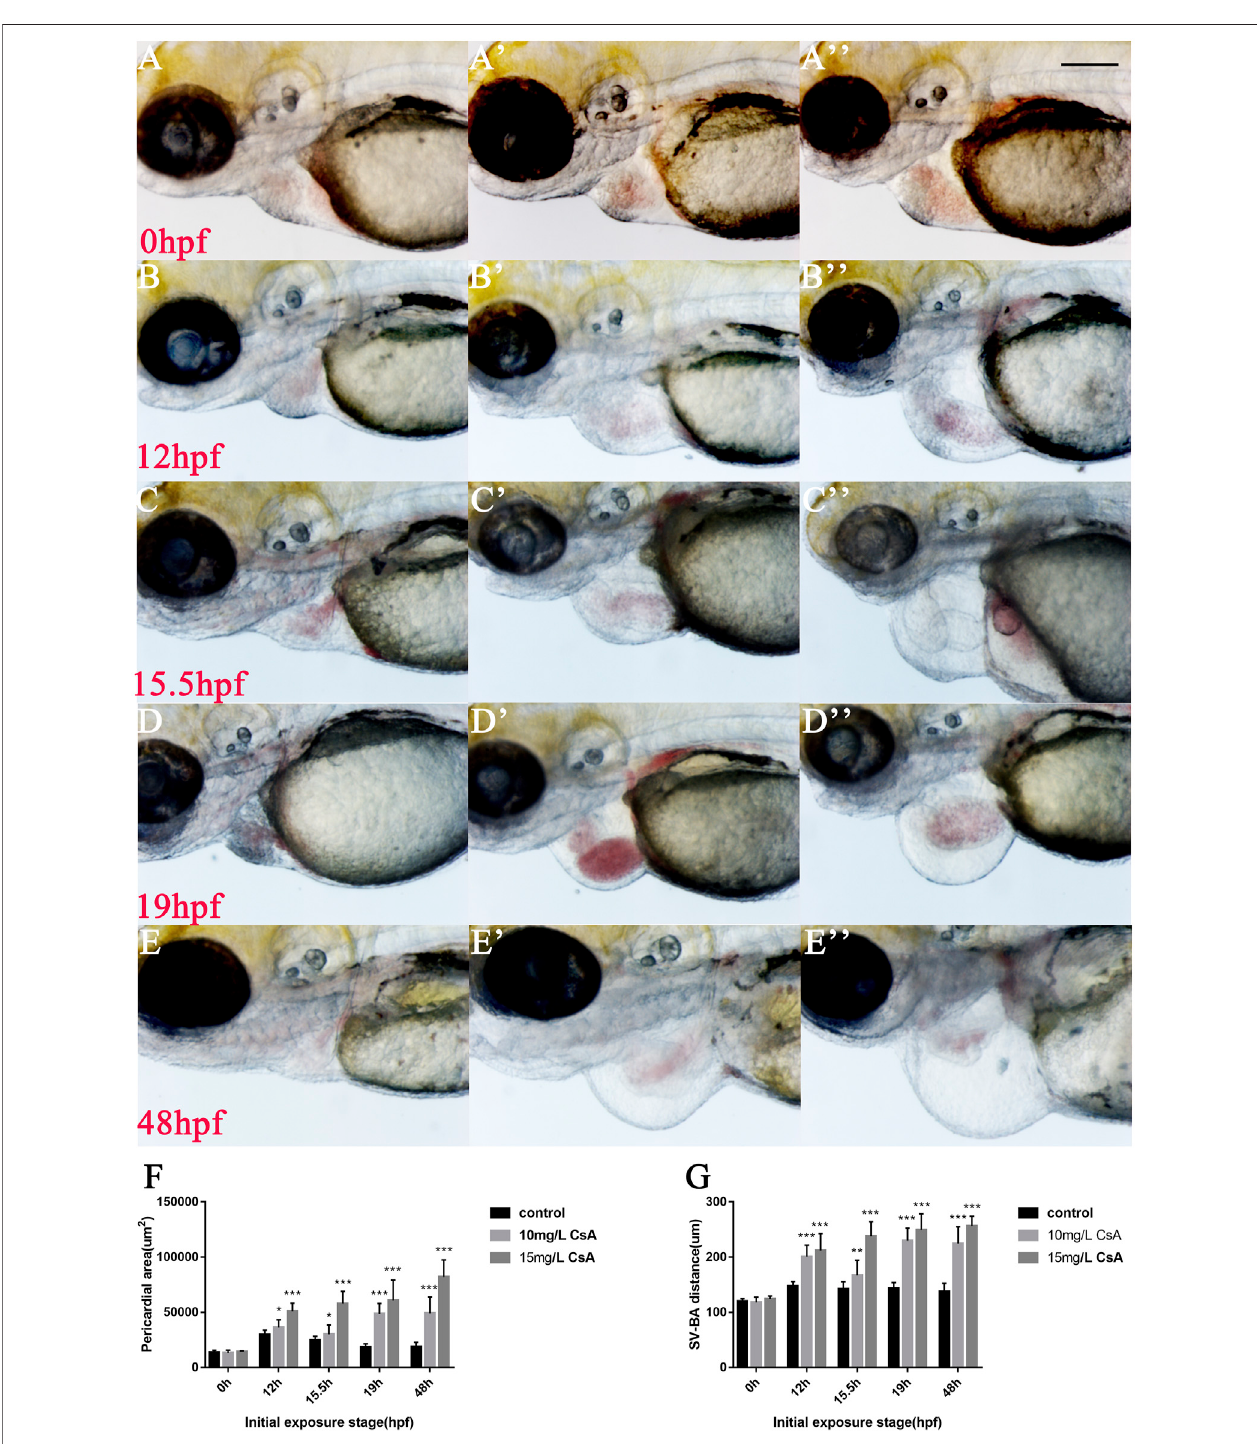
FIGURE 3 | Cardiac developmental defects in zebra fi sh embryos induced by CsA exposure at different time periods. (A-E) The images of cardiac development in zebra fi shembryosat0,12,15.5,19and48 hpfexposedto10 mg/Land15 mg/LCsA. (F) Statisticalchartofpericardialareaofzebra fi shembryosat0,12,15.5,19and 48 hpfexposedtoCsA(Comparedwithcontrol:** p < 0.01,*** p < 0.001,mean ± S.D) (G) StatisticalchartofthedistanceofSV-BAofjuvenilezebra fi shat0,12,15.5,19 and 48 hpf exposed to CsA (Compared with control: ** p < 0.01, *** p < 0.001, mean ± S. D). Scale bars:100 µm (A-E) .